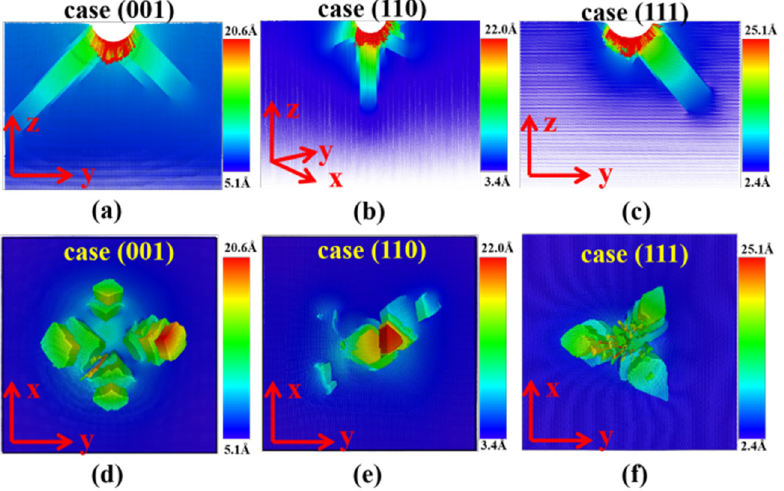
Figure 5. ( a – c ) The atomic displacement vectors in a slice (thickness of 1 nm) that passing through the center of the spherical indenter at h = 5.0 nm. ( d – f ) The bottom views of the atomic displacement vectors in a slice (1 nm thick) at the position of 8.5 nm below the indented planes.